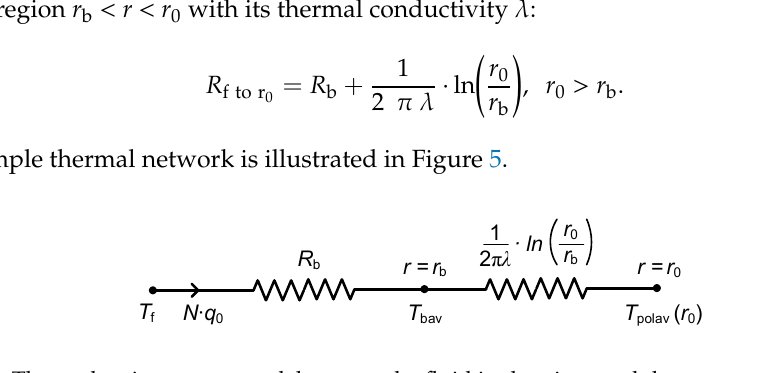
Figure 5. Thermal resistance network between the fluid in the pipes and the average temperature at any radius r 0 > r b .